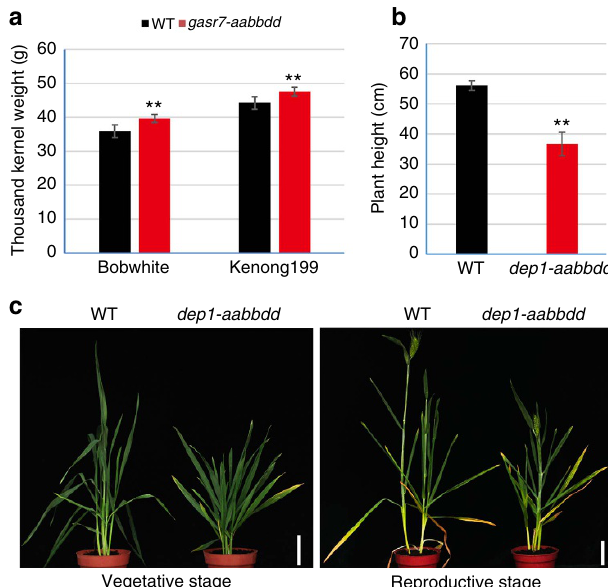
Figure 4 | Phenotypic analysis of TaGASR7 and TaDEP1 mutants generated using TECCDNA genome-editing method. ( a ) TKW of WT and tagasr7-aabbdd mutant Bobwhite and Kenong199 plants. Data are from eight replicates for Bobwhite and ten replicates for Kenong199. ( b ) Plant heights of tadep1-aabbdd mutant plants compared with WT. Data are from 15 replicates. Values in a , b are mean ± s.d. ** P o 0.01 ( t -tests). ( c ) The morphology of plant heights of Kenong199 for WT and tadep1-aabbdd mutant in the vegetative and reproductive growth stages. Scale bar,